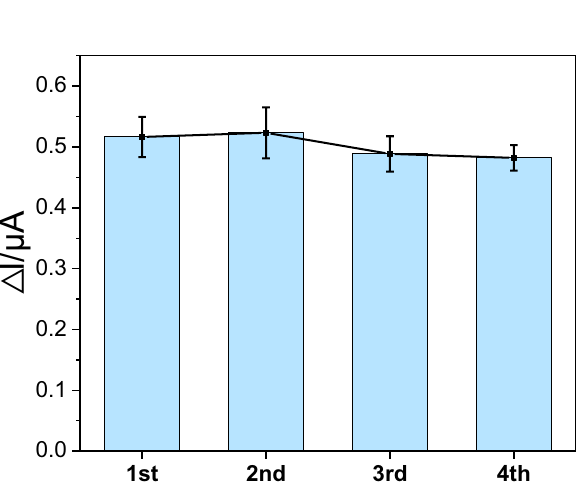
Figure 6. Current gap value of 100 pg/mL of GAPDH tested on different